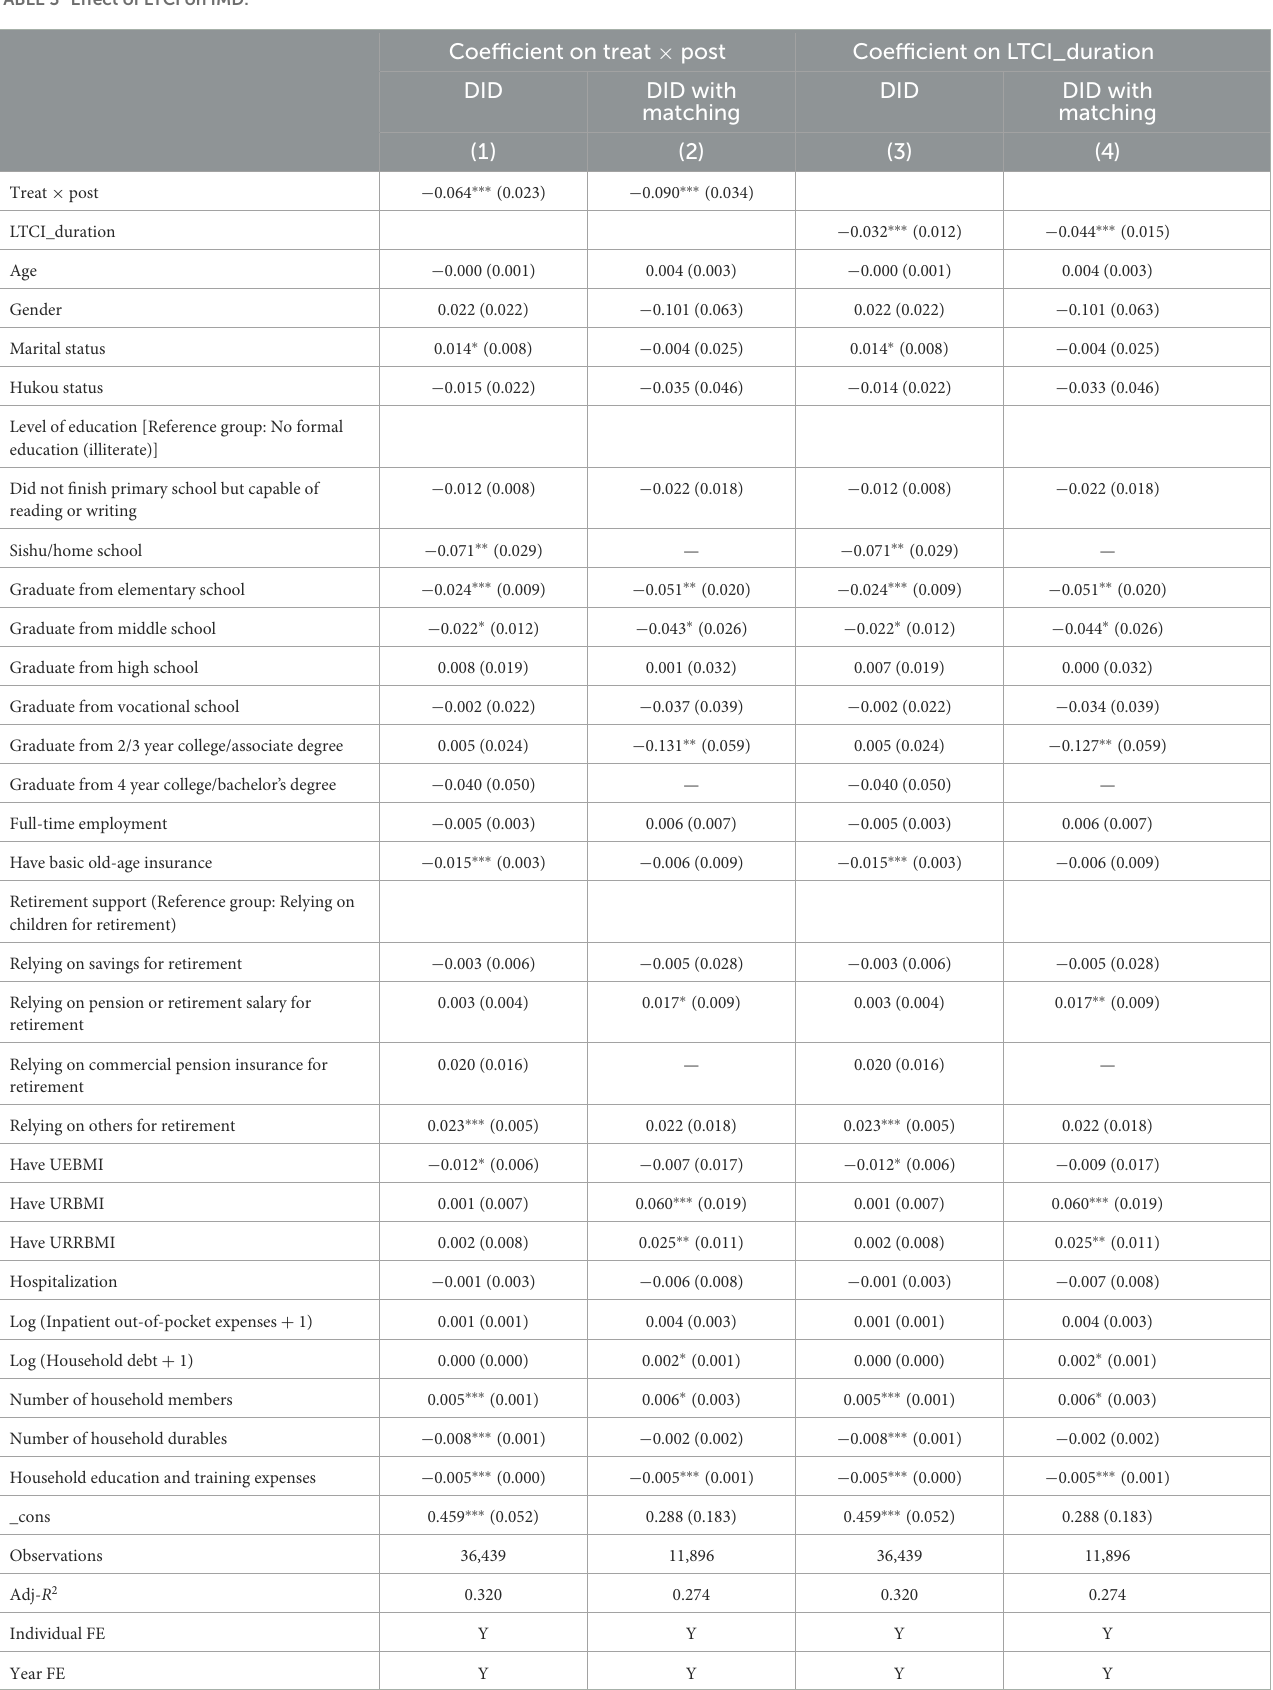
TABLE 3 Effect of LTCI on IMD.